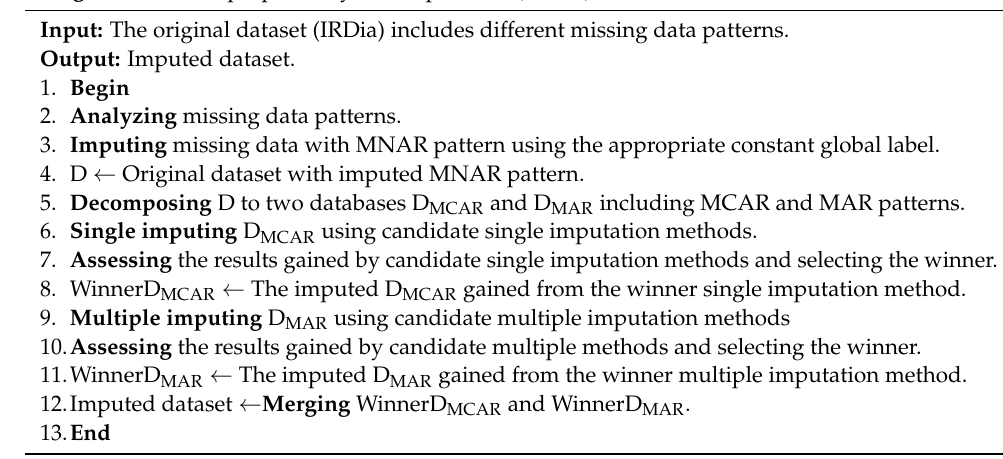
Algorithm 1. The proposed hybrid imputation (HIMP) method